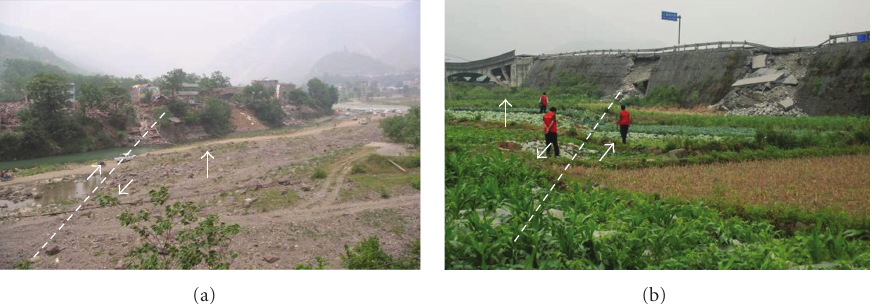
Figure 4: Strike-slip movement with thrust surface rupture.